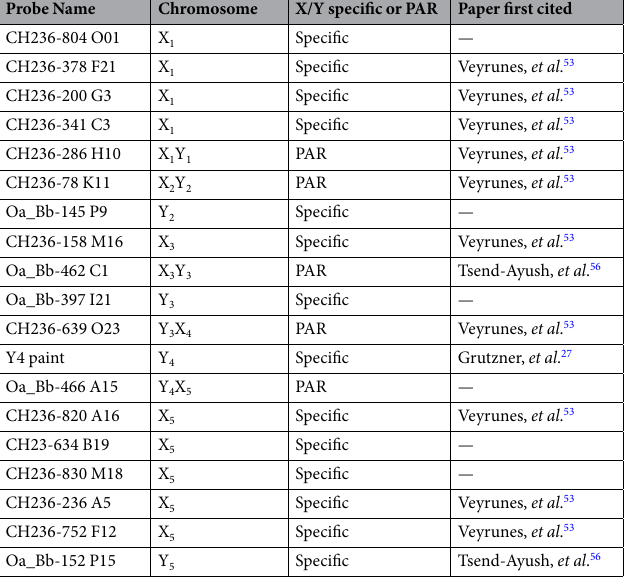
Table 1. Probes used in DNA FISH experiments * . * Probes were purchased from two libraries, the female platypus library held at the Children’s Hospital Oakland Research Institute (CH236) and the male platypus library from the CUGI BAC/EST Resource Centre, Clemson, South Carolina USA